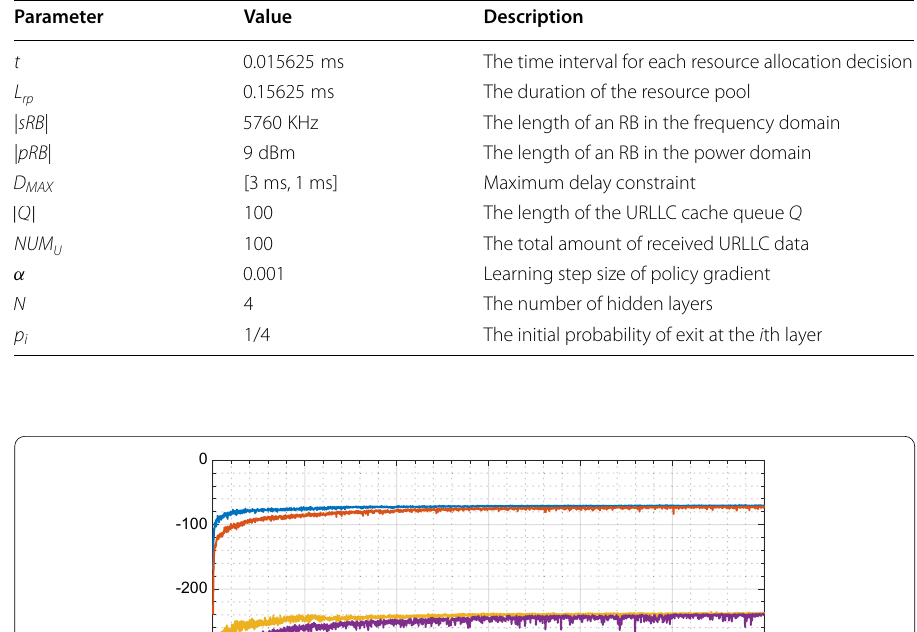
Table 1 Partial parameter settings